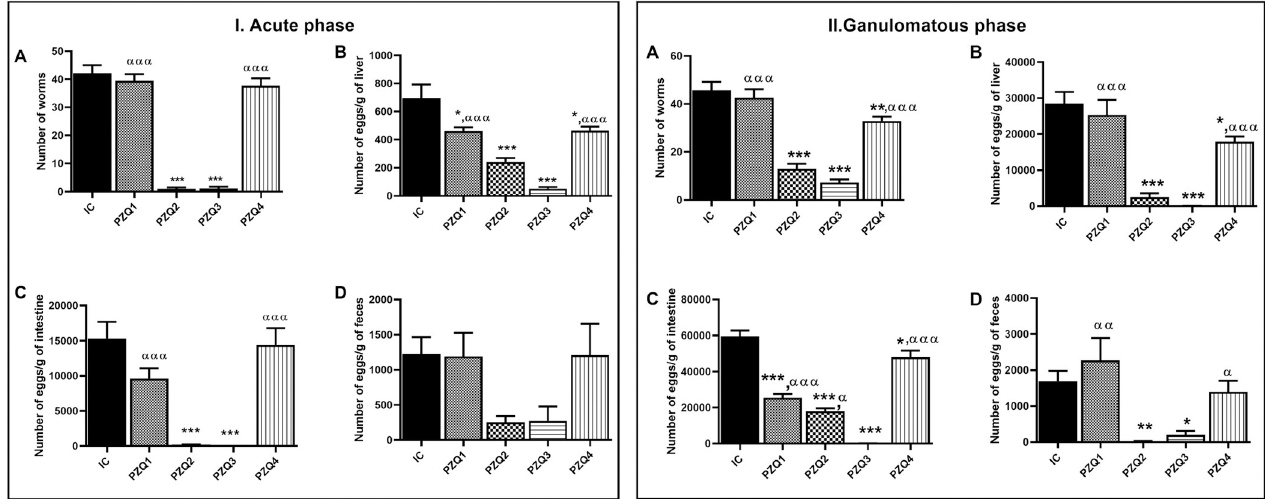
Fig 3. Effect of praziquantel treatment on the worm burden (A) and the hepatic (B), intestinal (C), and fecal (D) egg loads on Schistosoma mansoni acute (I) and granulomatous (II) phase of infection in mice. IC: Infected-untreated mice, PZQ1: Infected mice treated with praziquantel at 100 mg/kg for 5 consecutive days, PZQ2: Infected mice treated with praziquantel at 100 mg/kg for 28 consecutive days, PZQ3: Infected mice treated with praziquantel at 18 mg/ kg for 28 consecutive days, PZQ4: Infected mice treated with a single dose of praziquantel at 500 mg/kg. Data are expressed as mean ± SEM (n = 6). ANOVA followed by Tukey multiple comparison test was also used for statistical analysis. � p < 0.05, �� p < 0.01, ��� p < 0.001: values are significantly different from those of infected-untreated mice (group IC). α p < 0.05, αα p < 0.01, ααα p < 0.001: values are significantly different from those of infected mice treated with PZQ3 posology (group PZQ3).